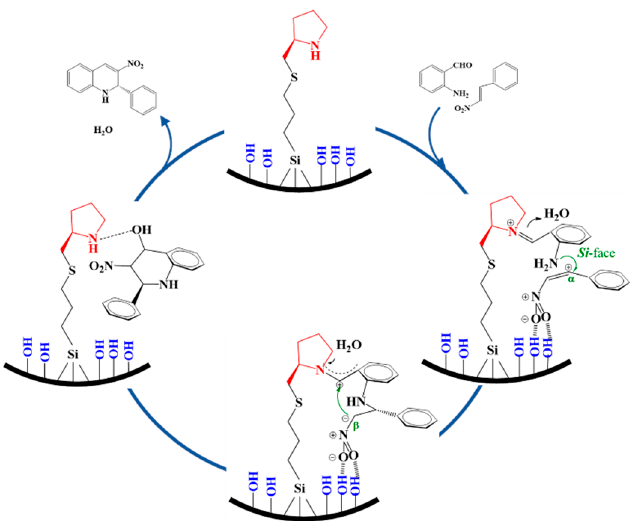
Figure 2. The proposed heterogeneous catalytic mechanism for SBA-15-PY in the aza-Michael–Henry cascade reaction.